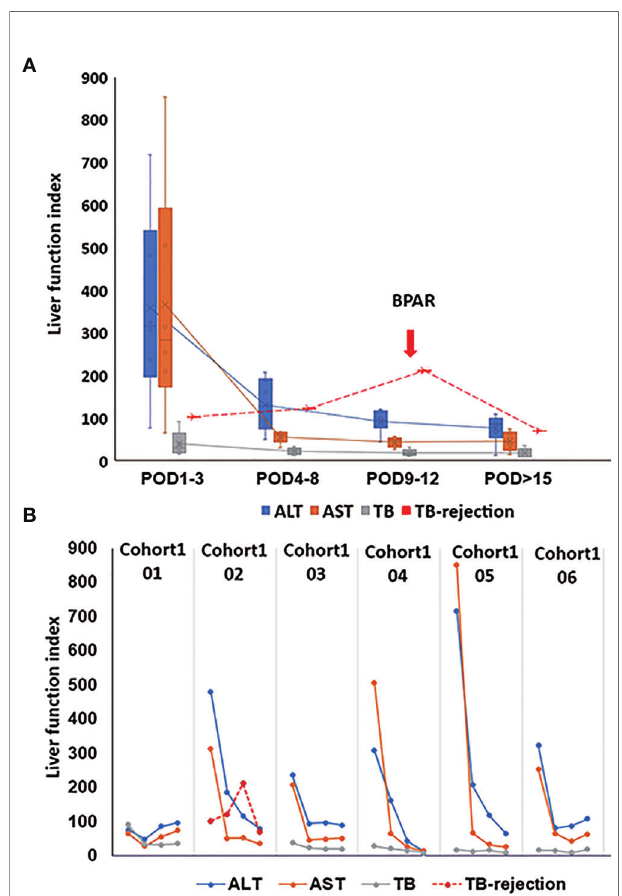
FIGURE 1 | Post-transplant liver function. (A) The change of average ALT, AST, and TB from POD1 to POD>15. The redline of TB rejection presents the change of TB for the patient with BPAR; BPAR occurred inthe combination of high TB. (B) The presentative liver function from six out of seven patients incohort1. For patient02 in cohort1, histransaminase increased with a peakAST levelat 785 U/L on POD1 and graduallydecreased. However, his TB level continuedto grow after the surgery. On POD10, his TB reached 309.8 m mol/L. As a possibilityof BPAR was suspected, he underwent a puncture liver biopsy onPOD 11. The pathological results suggesteda mildacute rejection(rejectionactivity index, RAI=2+1+2 = 5). Simultaneously, a dose of500 mg of methylprednisolone was givenfrom POD11, then tapered down and discontinuedonPOD16. The patient ’ s TB level fellbelow 100 m mol/L and did not increase subsequently. ALT, alanine aminotransferase; AST, aspartate aminotransferase; TB, total bilirubin; biopsy-proven acute rejection